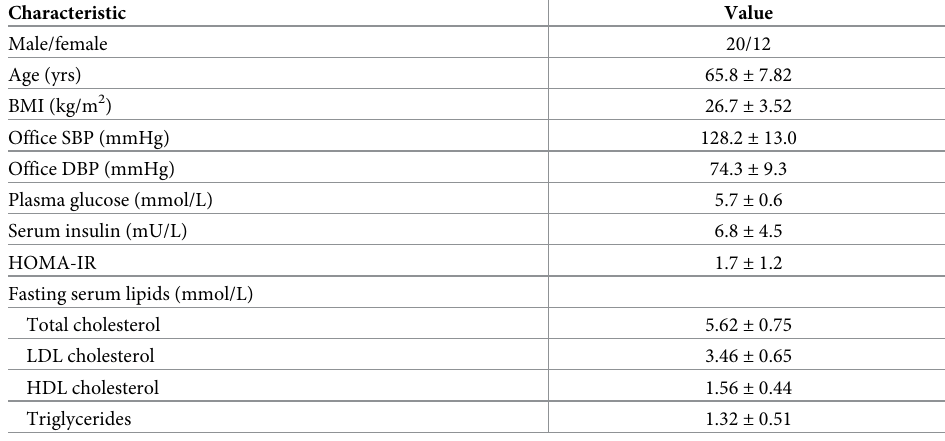
Table 1. Baseline characteristics of 32 untreated (pre)hypertensive healthy subjects included in the microarray analysis.